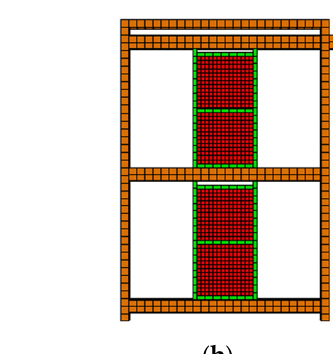
Figure 4. Computation models. ( a ) Computation model of the EDCW; ( b ) computation model of the steel frame.